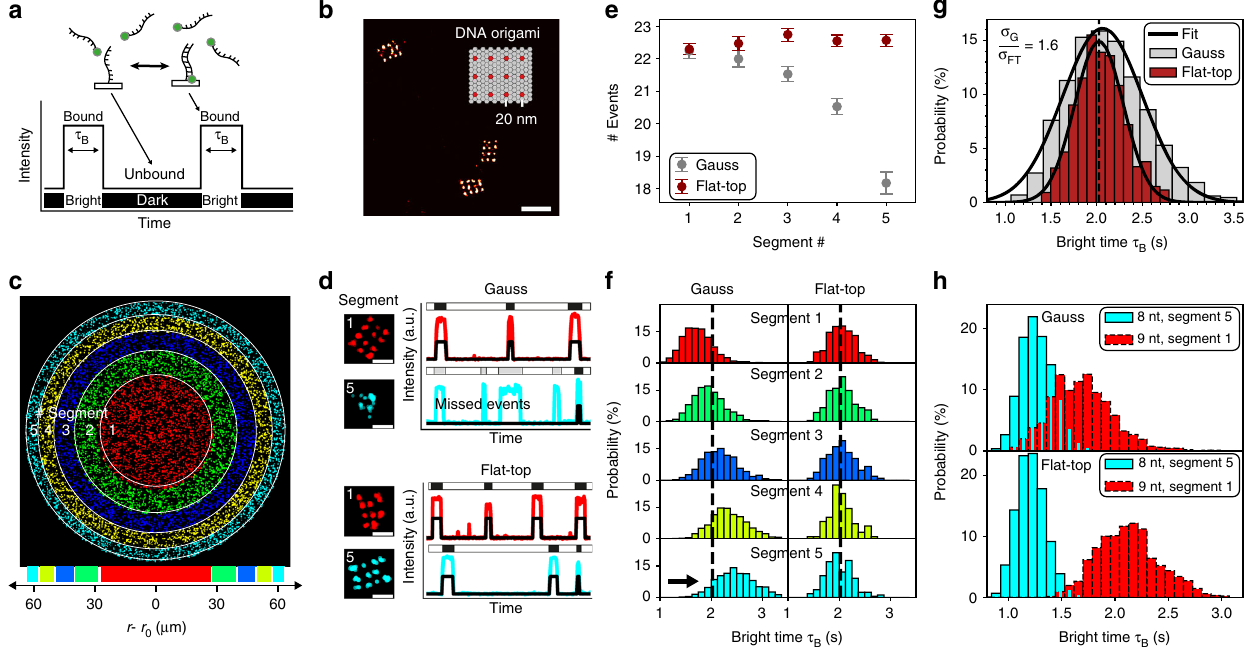
Fig. 2 Flat-top illumination improves single-molecule detection and enables precise binding time quanti fi cation. a Schematic of DNA-PAINT: dye-labeled imager strands reversibly bind to complementary docking sites that are attached to the target of interest. Binding events result in apparent target blinking required for single molecule localization microscopy (SMLM). b DNA-PAINT image of rectangular DNA origami designed to display a 20-nm-grid pattern of docking strands (inset displaying origami design). c Whole-sCMOS-chip fi eld of view (FOV) of several thousand DNA origami. Images acquired with Gaussian and fl at-top illumination are both segmented into concentric rings containing equal numbers of origami (~800 origami per segment) for downstream quanti fi cation. d Exemplary DNA origami and intensity traces from inner and outer segment (red and cyan, respectively) showing that binding events in the outer segment are missed by the spot detection algorithm for Gaussian illumination. e The effect illustrated in d leads to a decrease in the mean number of binding events per origami with radial distance for the Gaussian pro fi le. Flat-top illumination allows robust spot detection over the whole FOV. f Inhomogeneous photobleaching of imager strands increases the mean bright time with radial distance for Gaussian illumination. g The effect observed in f leads to an overall broadening of the bright time distribution over the whole FOV. h Distinction of docking strands of different length via bright times. Position-dependent bright times for Gaussian illumination lead to non-separable populations. Scale bars, 20 nm in b and 40 nm in d . Error bars in e correspond to SEM